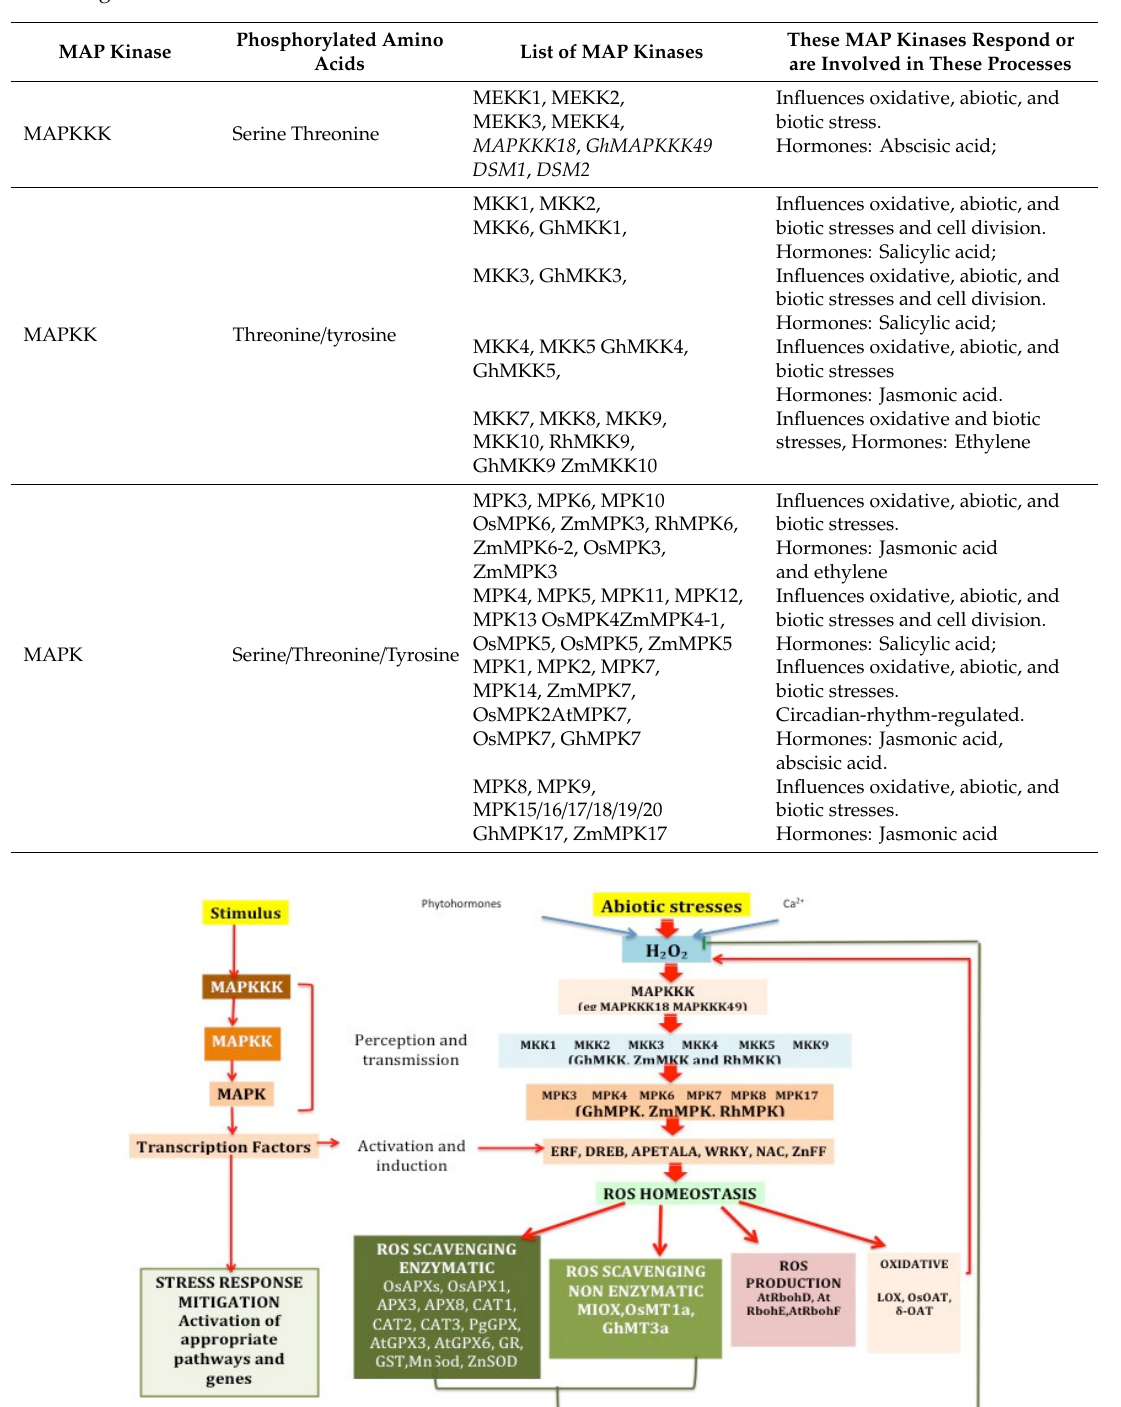
Figure 5. The pathway taken from the time of stimulus to the activation of genes downstream and the genes involved in the regulation of this pathway. Table 1. List of mitogen-activated protein (MAP) kinases and the processes they are implicated to regulate.